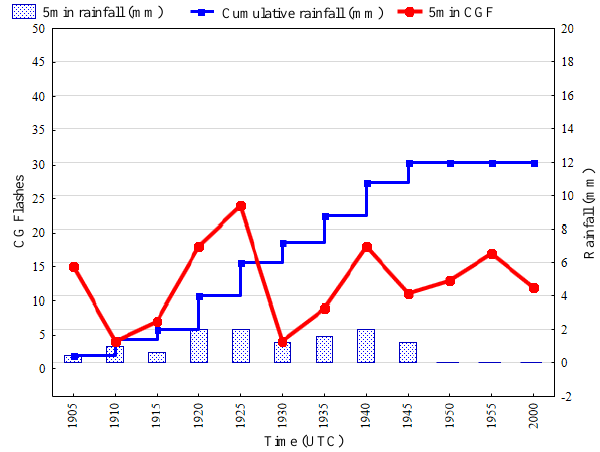
Figure 14. Critical interval time series for debris flow event of 5 July 2006. This is an event from the STH group and debris flow initiation was observed at 16:30UTC.